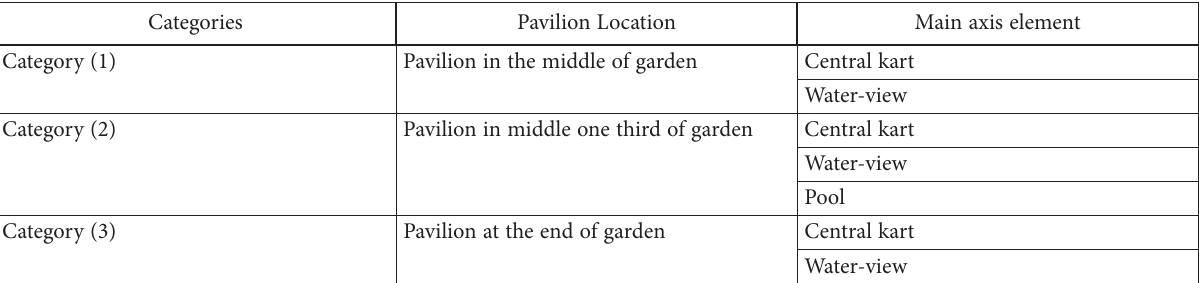
Table 1. Garden classification based on pavilion location (source: authors)